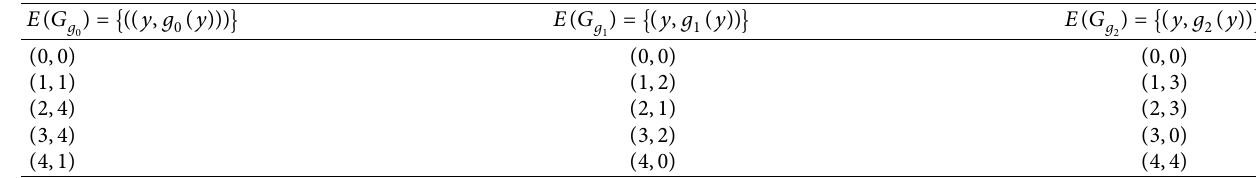
G G g 0 , g 1 , and g 2 for Example 5.